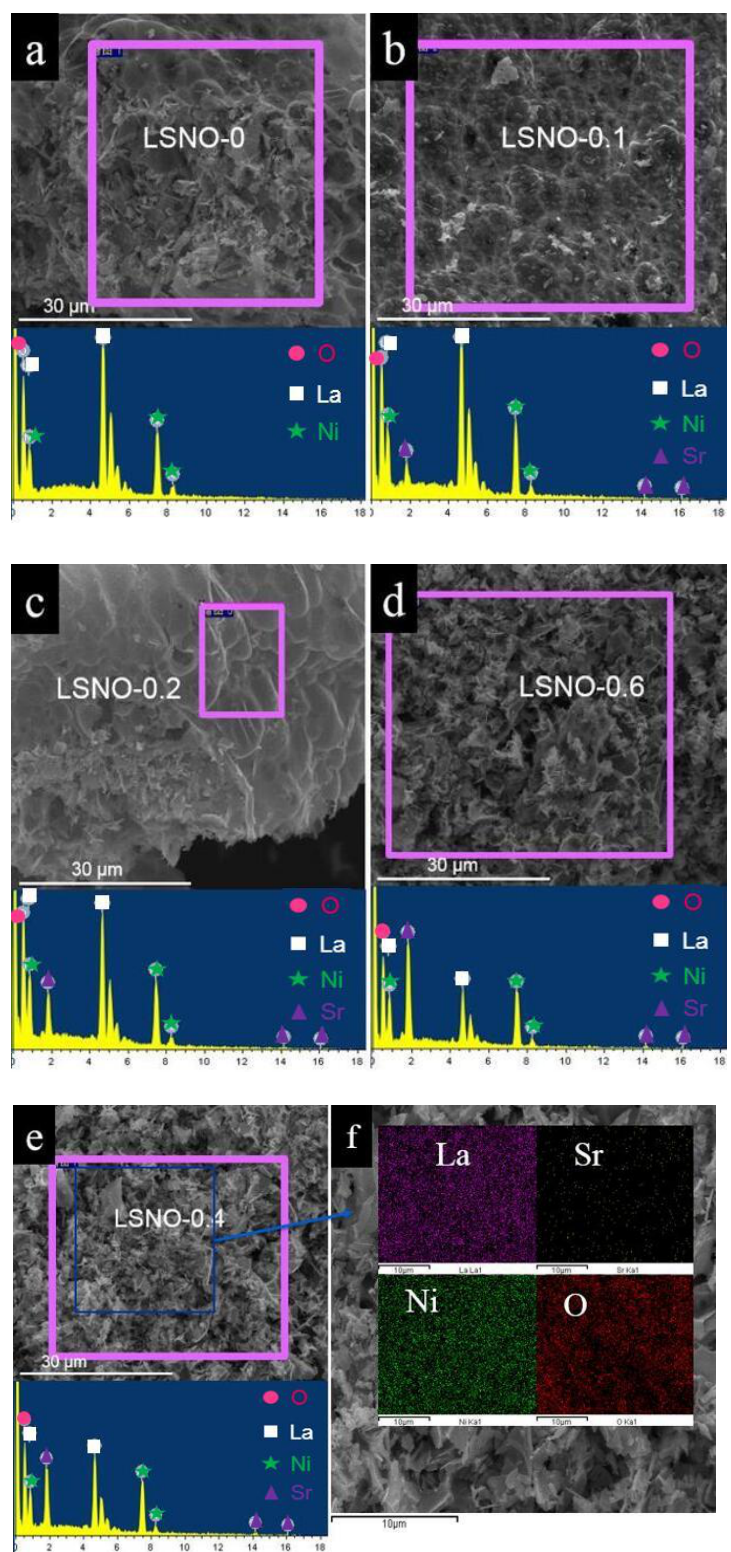
Figure 2. SEM images of LSNOs sample. ( a – c ) LSNO-0; ( d – f ) LSNO-0.1; ( g – i ) LSNO-0.2; ( j – l ) LSNO-0.4; ( m – o ) LSNO-0.6.